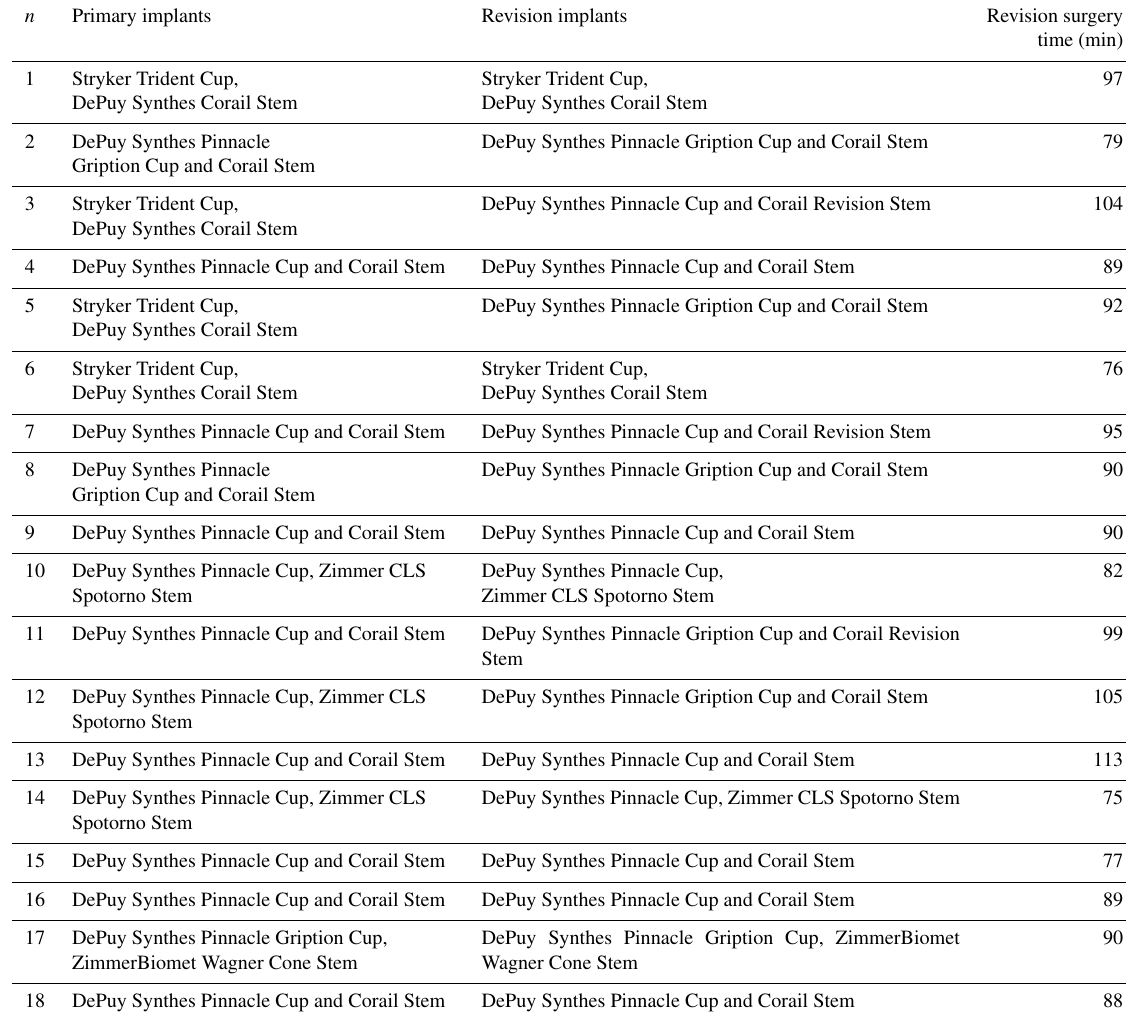
Table 3. Implants and surgery